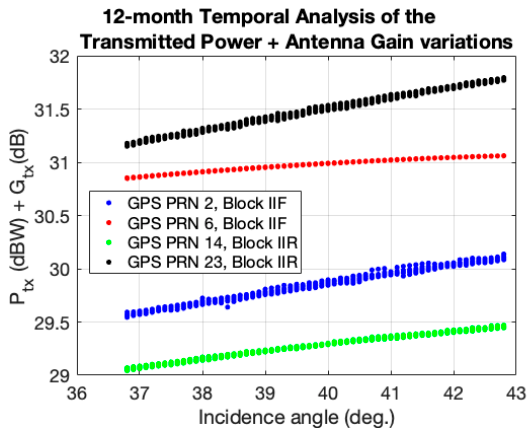
Figure 8. Temporal analysis of the variations in the combined transmitted power and gain observed for four GPS satellites over a period of 12 months. Mean variability observed in the vertical axis is due to antenna gain variations with respect to incidence angle. The standard deviation of the variability observed in the vertical axis is due to antenna gain variations with respect to azimuth angle.